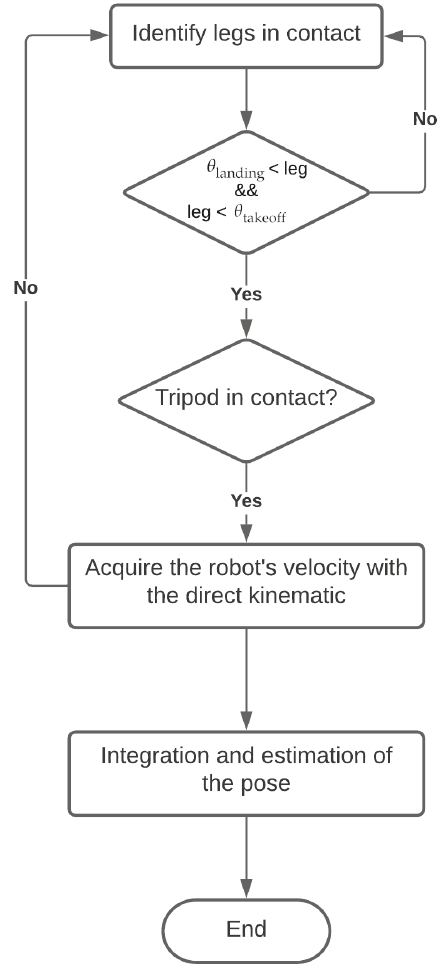
Figure 7. Odometry model steps.